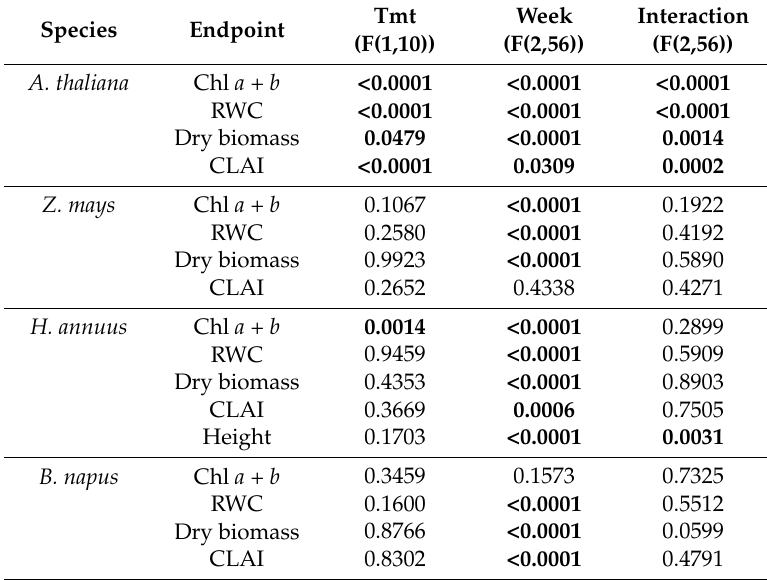
Table 1. Results ( p -values) of initial statistical analysis of measured endpoints. Bold numbers indicate significance at the 0.05